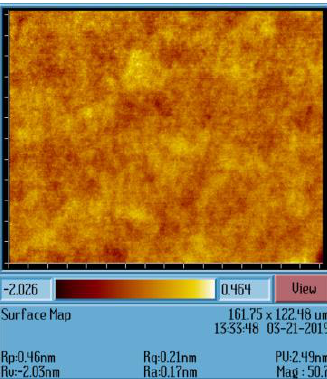
Fig. 1. Cross section profile of laser machined area before (black) and after plasma jet polishing (blue).